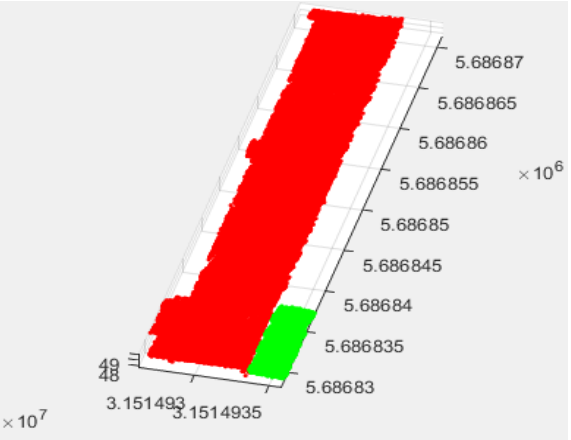
Figure 2. Roof segmentation.